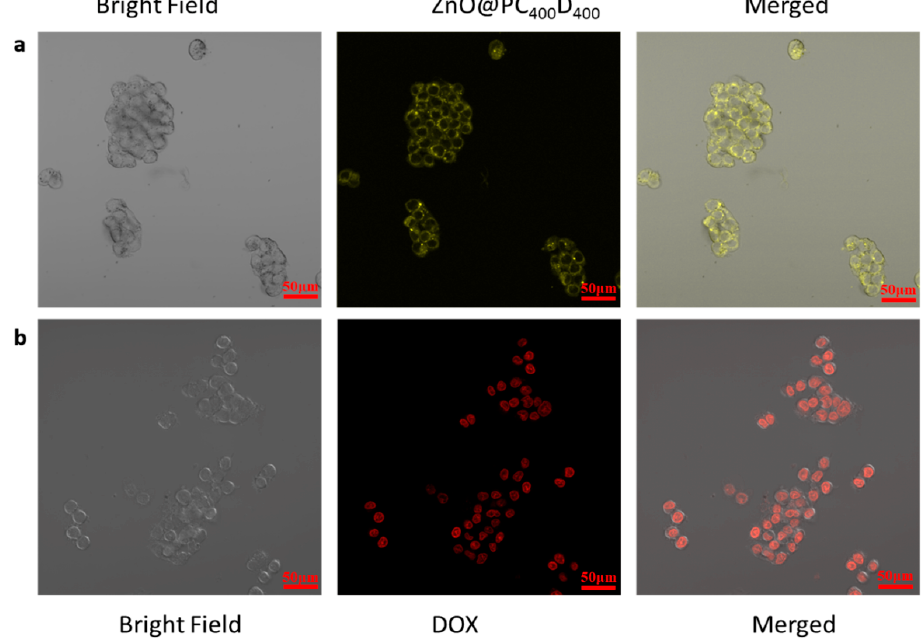
Figure 7. CLSM images in a culture of HepG2 cells of incubation with ( a ) ZnO@PC 400 D 400 after 4 h and ( b ) ZnO@PC 400 D 400 -DOX after 8